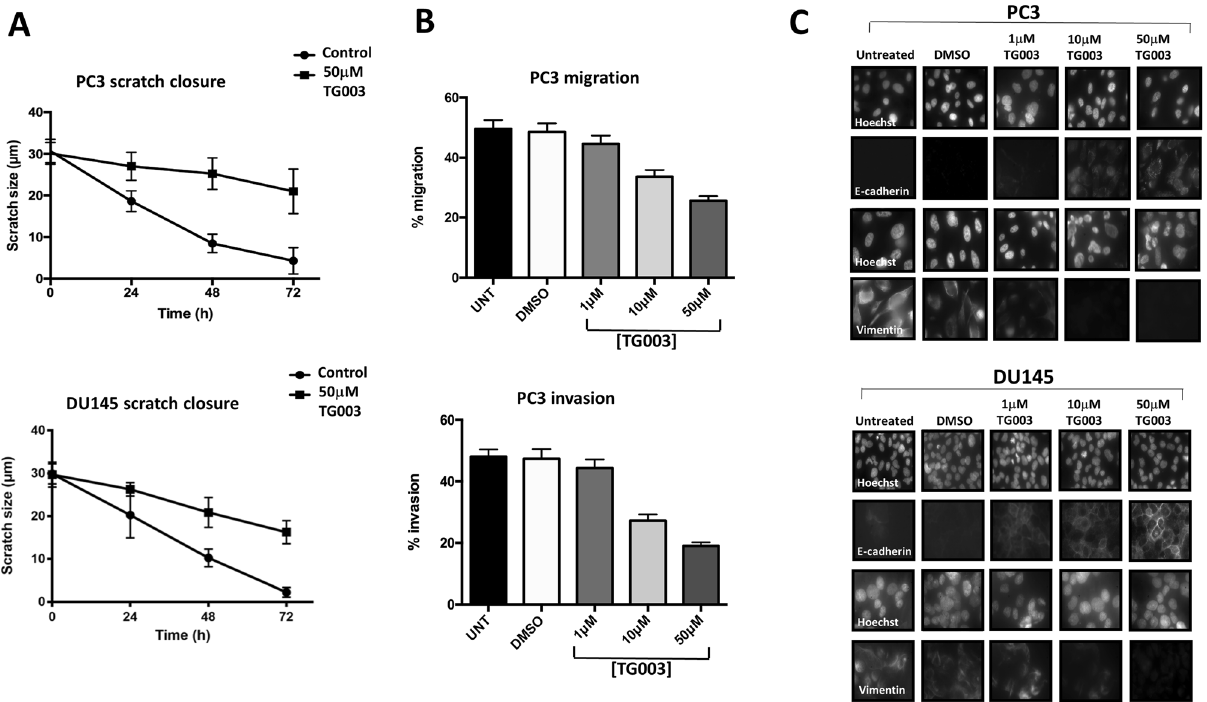
Figure 2. Effect of TG003 on scratch closure, cell migration and invasion. ( A ) 30 µm scratches were applied to confluent cell monolayers and allowed to close over 72 h. PC3 and DU145 cells were treated with 50 µM TG003. ( B ) Cell migration and invasion were measured using a transwell assay following treatment of PC3 cells with 1, 10 and 50 µM TG003. ( C ) Following treatment of PC3 and DU145 cells with 1, 10 and 50 µM TG003, E-cadherin and vimentin expression was determined by immunohistochemistry; with Hoechst counterstain. N = 3 repeats in all experiments. * p < 0.05; ** p < 0.01; *** p < 0.001; **** p <